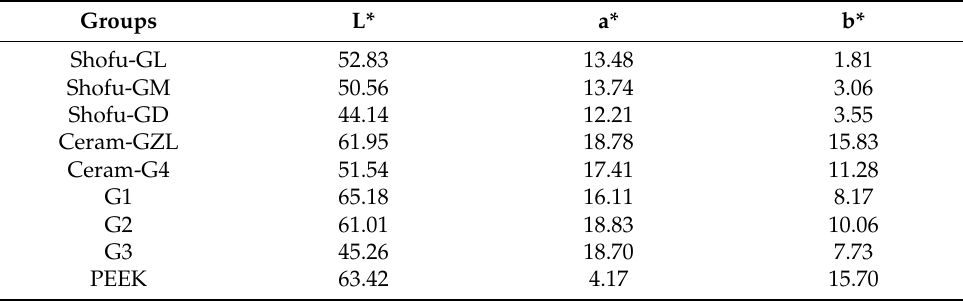
Table 6. Color coordinates of gingiva shade guide and pink PEEK specimens.